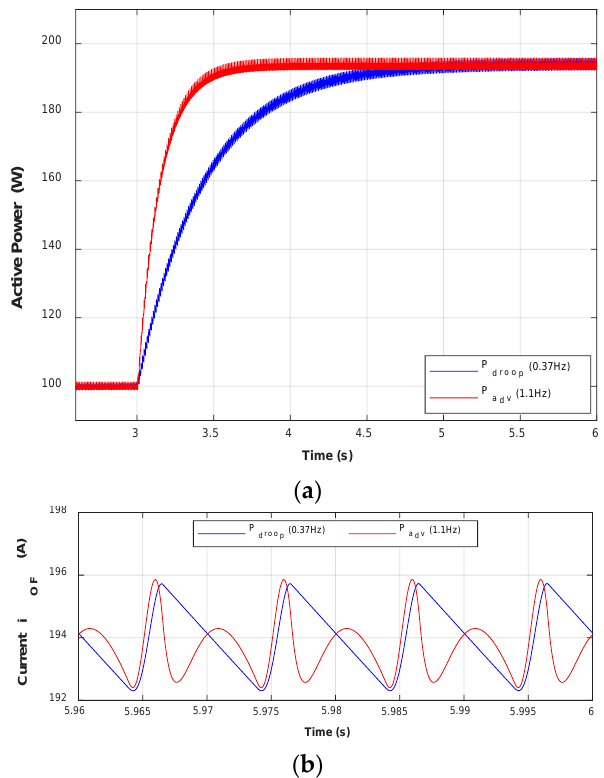
Figure 12. Simulation of the P av transient responses for a nonlinear DBR (diode bridge rectifier) load current perturbation from a peak at 2.48 A to a peak at 4.15 A at 3 s: ( a ) P adv (with reduced fc = 1.1 Hz) and P droop , ( b ) detail of P adv and P droop ripples.